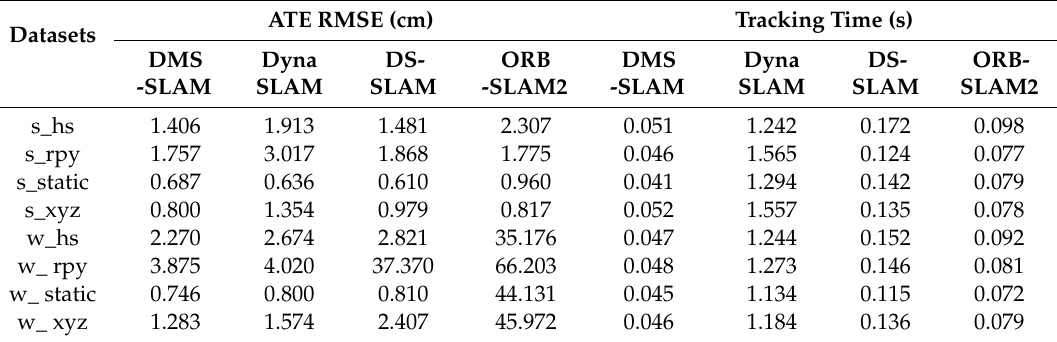
Table 2. Accuracy and speed in low dynamic scenes (s_*) and high dynamic scenes (w_*). Datasets ATE RMSE (cm)